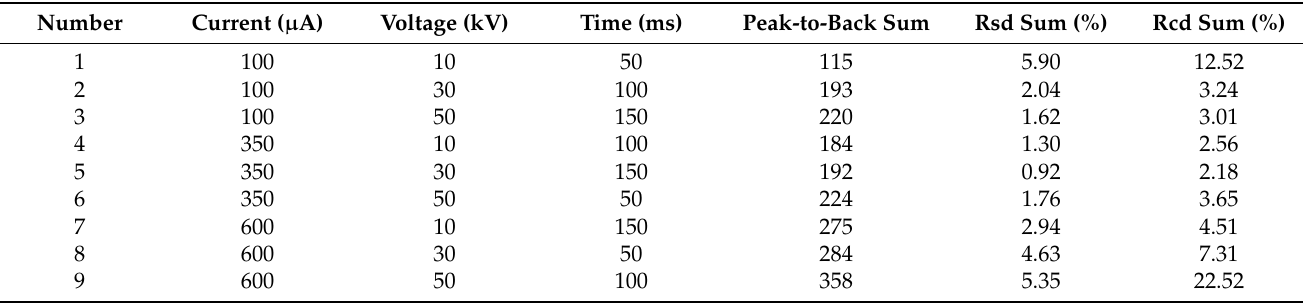
Table 3. Orthogonal experiment table of instrument parameter